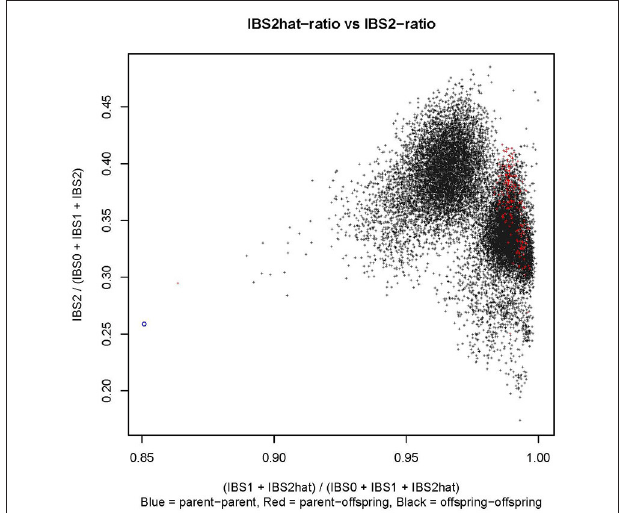
FIGURE 1 | Identity by state (IBS) plot for the mapping population constructed using the GBS data. In the figure, parent–parent comparisons are represented by a blue circle, parent–offspring comparisons by red dots and offspring–offspring comparisons by black